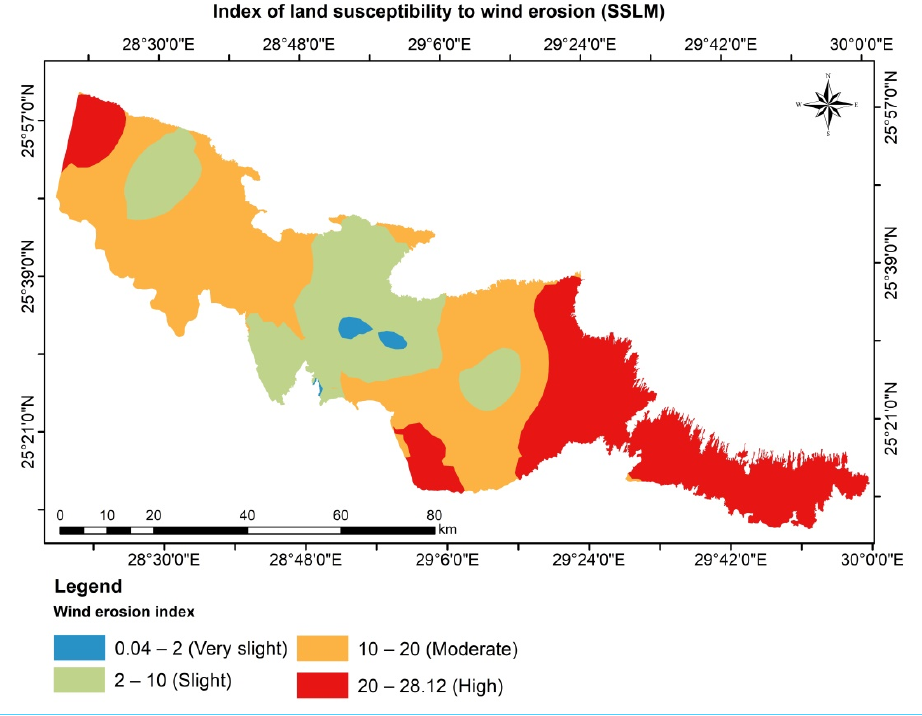
Figure 15. Spatial distribution map of wind erosion indexes and classes according to the SSLM.